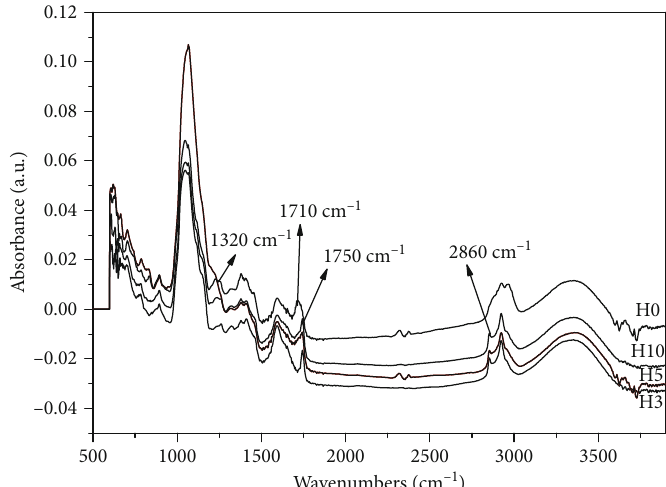
Figure 9: FTIR spectra for hydrogels prepared from CMCNa and HEC (3% wt) at the weight ratio 3: 1 at di ff erent concentrations of